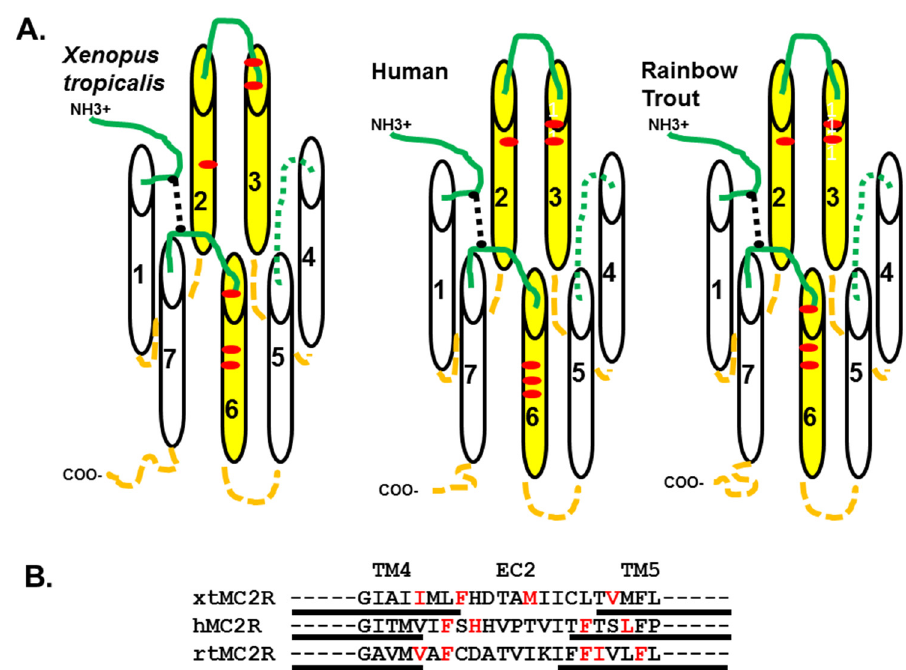
Figure 5. Schematic representation of human, rainbow trout, and X. tropicalis MC2R. The diagrams for the proposed positioning of transmembrane domains in the MC2R orthologs for X. tropicalis , human, and rainbow trout is based on the alignments presented in Figure 1, and the presence of a disulfide bridge between cysteine residues in TM1 and TM7 that is essential for functional activation of the receptor. The transmembrane domains (TM) are represented as numbered cylinders. TMs shaded in yellow form the proposed HFRW binding site. Extracellular domains are green lines. The N-terminal domain is capped with “NH3+.” Extracellular Loop 2 is shown as a green dotted line. Intracellular domains are orange dashed lines. The C-terminal domain is capped by “COO-.” The disulfide bridge between the TM1 and TM7 [32] is a black dotted line. In each diagram, critical residues associated with the proposed HFRW binding site are a red dot. In X. tropicalis MC2R the residues that may play a role in the HFRW binding pocket are E72 (TM2), D95 (EC1) and D99 (TM3), and W230, F233, and H236 (TM6). In human MC2R the residues that play a role in the HFRW binding